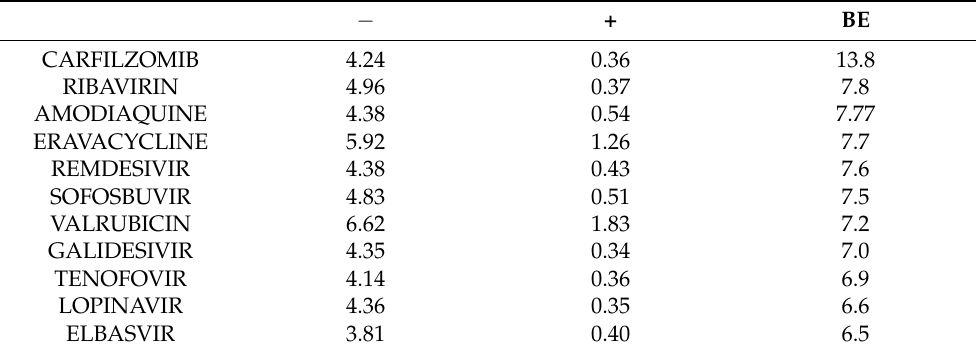
Table 2. Electron donor and electron acceptor powers of selected molecules are reported. Red values are for electron acceptor molecules, whilst blue values are for electron donors. Absolute values of Binding Energies (BE in kcal/mol) previously reported are included (see [13,15,16]). − + BE CARFILZOMIB 4.24 0.36 RIBAVIRIN AMODIAQUINE ERAVACYCLINE